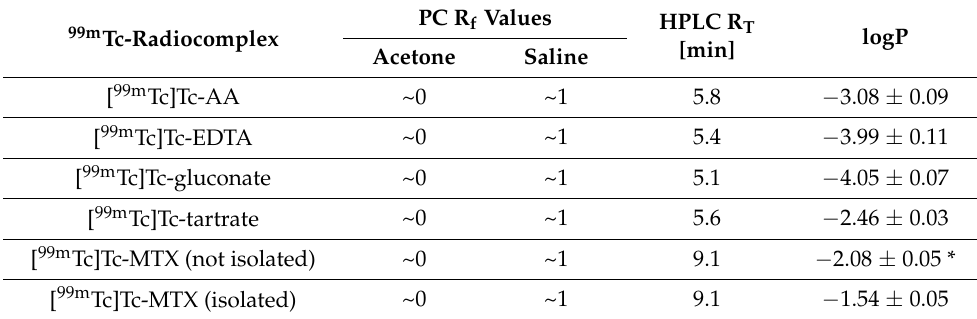
Table 5. Determined physicochemical parameters of the 99m Tc-complexes.